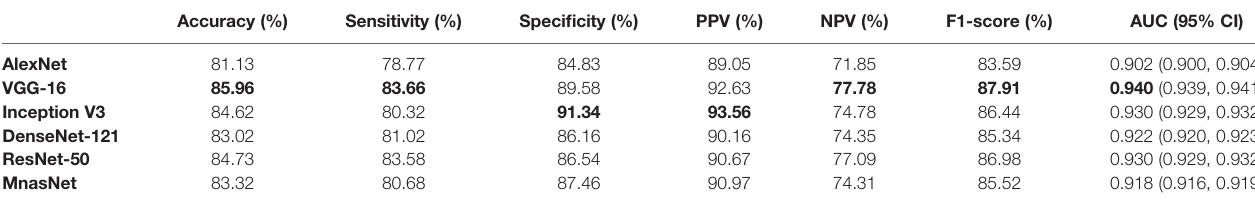
TABLE 1 | Performance of patch-level binary classi fi cation on testing dataset.